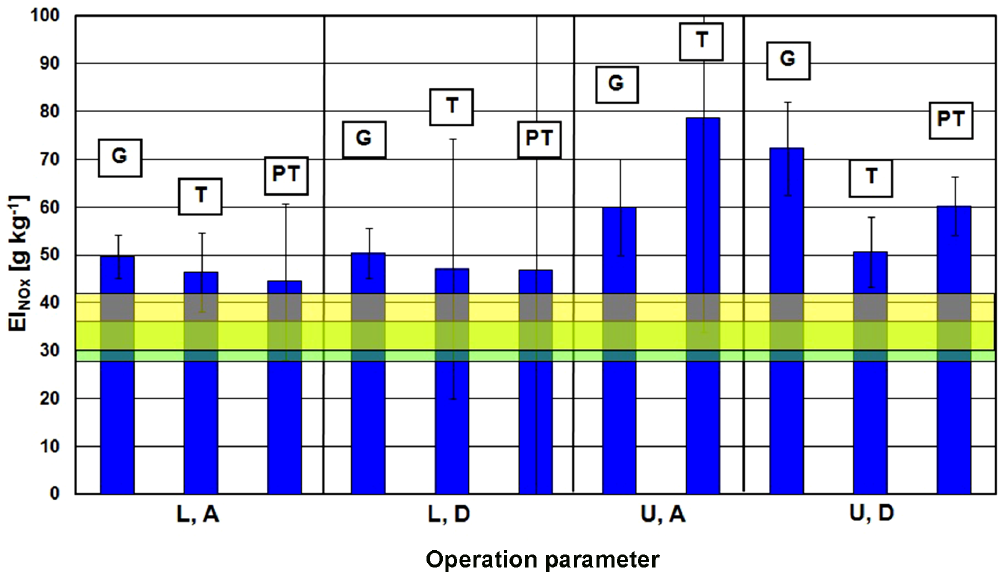
) in gkg − 1 burnt fuel for different motor ship types (G = goods, T = tanker Figure 8. Weighted average emission index for NO x (EI NO x and PT = push–tow) at different operation parameters (L = loaded, U = unloaded, A = upstream and D = downstream), in comparison with German guidelines (BinSchAbgasV, 2005 (yellow) and RheinSchUO, 2011